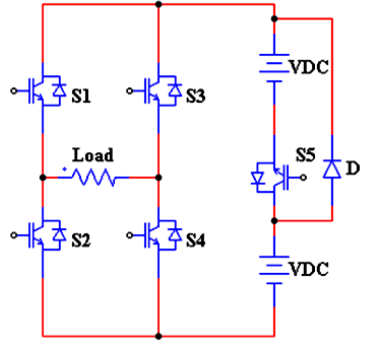
Figure 23. Basic unit and nine-level MLI.